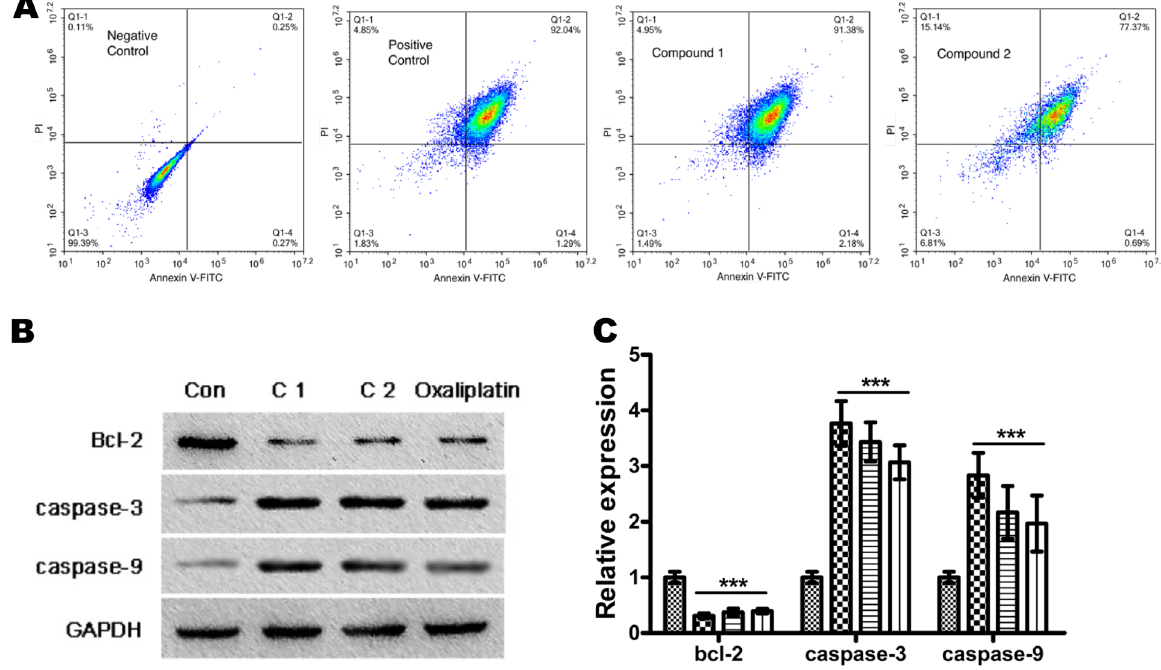
Figure 6. Effects of compounds 1 and 2 on OPM-2 cell apoptosis. A , Apoptotic OPM-2 cells were detected by fl ow cytometry following annexin V-FITC/PI double staining. B , The protein expression of Bcl-2, cleaved caspase-3, and cleaved-caspase-9 was detected by western blot. C , Statistical results of apoptotic protein expression. Representative results of three experiments are shown. Data are reported as means ± SD. ***P o 0.001 compared to control (small squares column) (ANOVA).